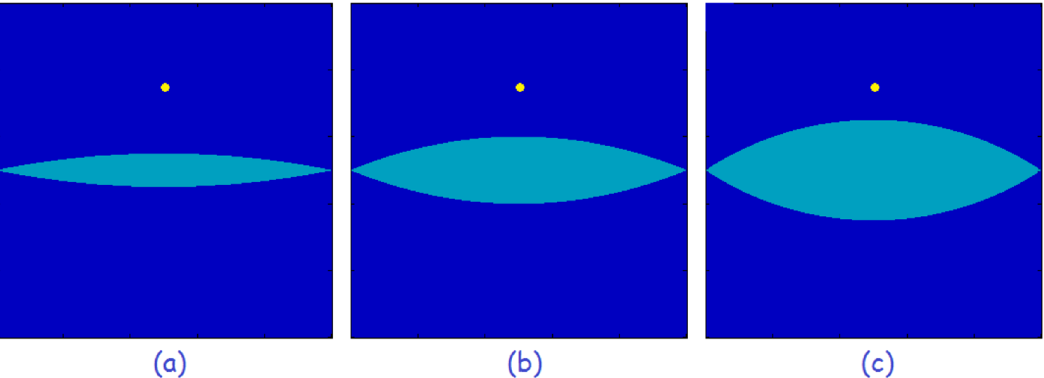
Fig. 2. Three convex lenses of increasing width 2 H at their center: (a) H = 2.5cm for Lens 1; (b) H =5cm for Lens 2 and (c) H =7.5 cm for Lens 3. All three lenses are 50cm wide (from left to right); the point force marked by the yellow dot is located on the orthogonal bisector at a distance 12.5 cm from the top of the lens. The mass density is 1.85 larger inside the lens than in the